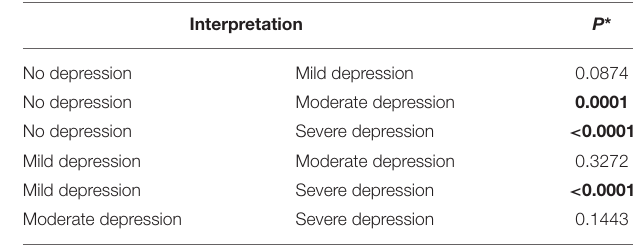
TABLE 3 | Comparison of individual COVID-19 pandemic waves between BDI and GAD-7 interpretations. Stage of the study Stage of the study p * BDI